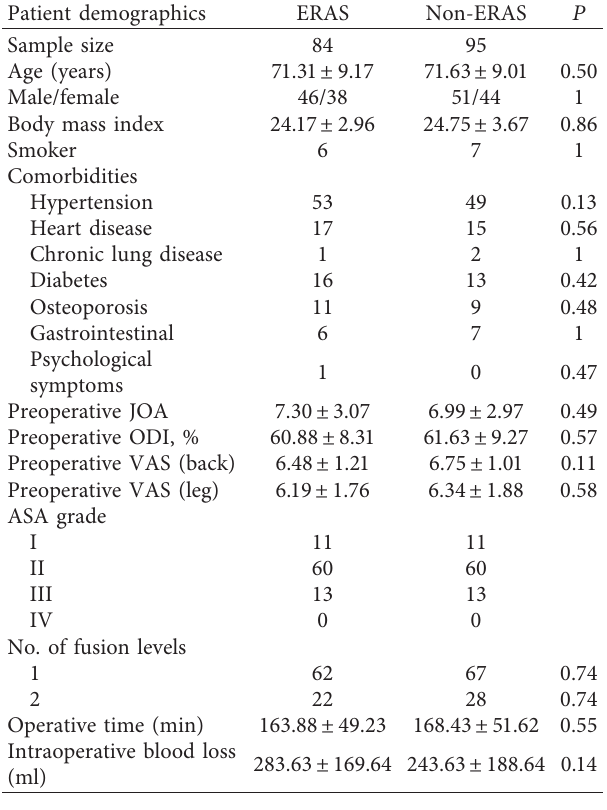
Table 1: Patient demographics.